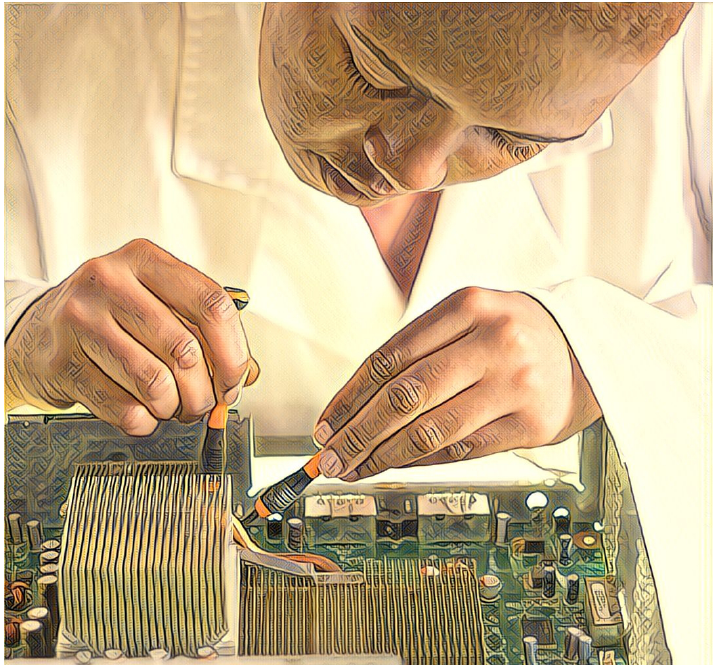
Figure 9. An illustration of SAIT for hardware engineer